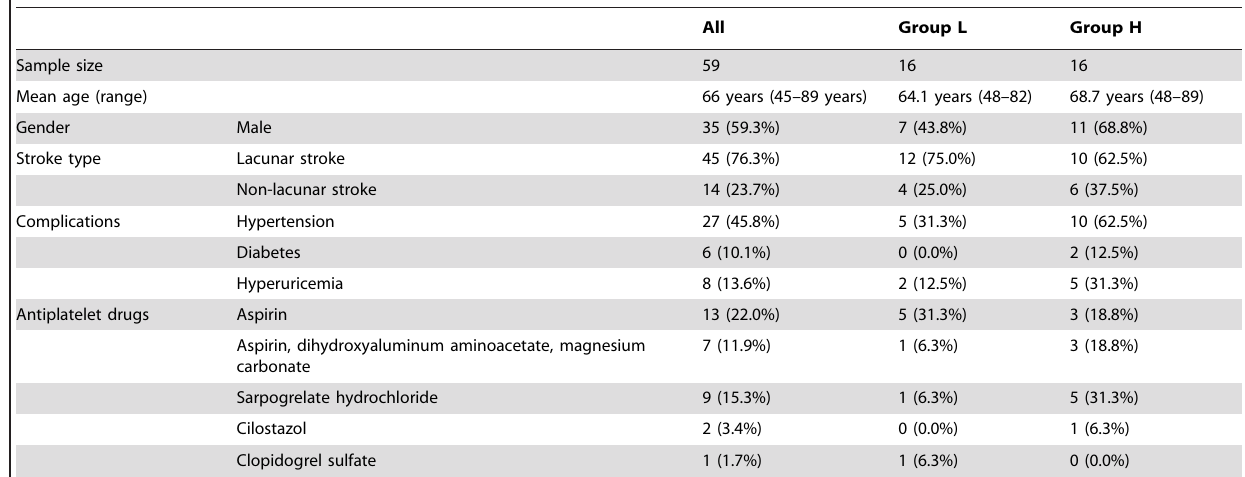
Table 1. Patient